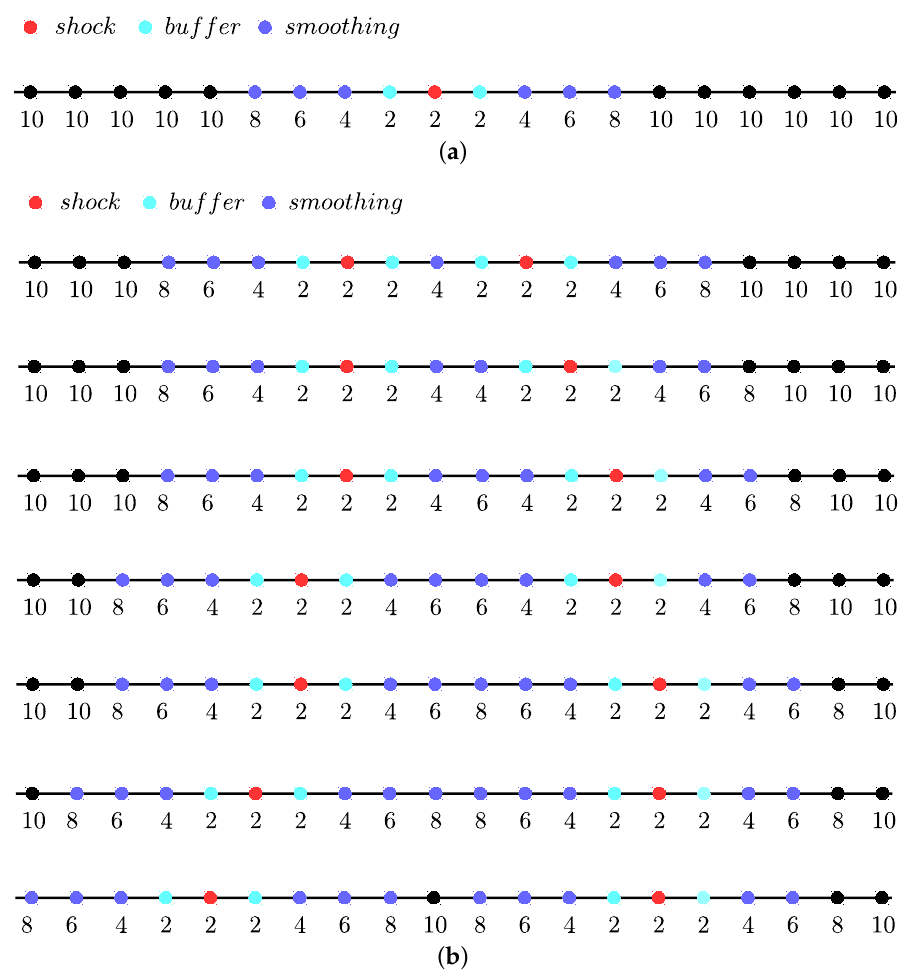
Figure 2. Scheme for changing filter order near isolated and proximate shocks: ( a ) isolated shock; and ( b ) proximate